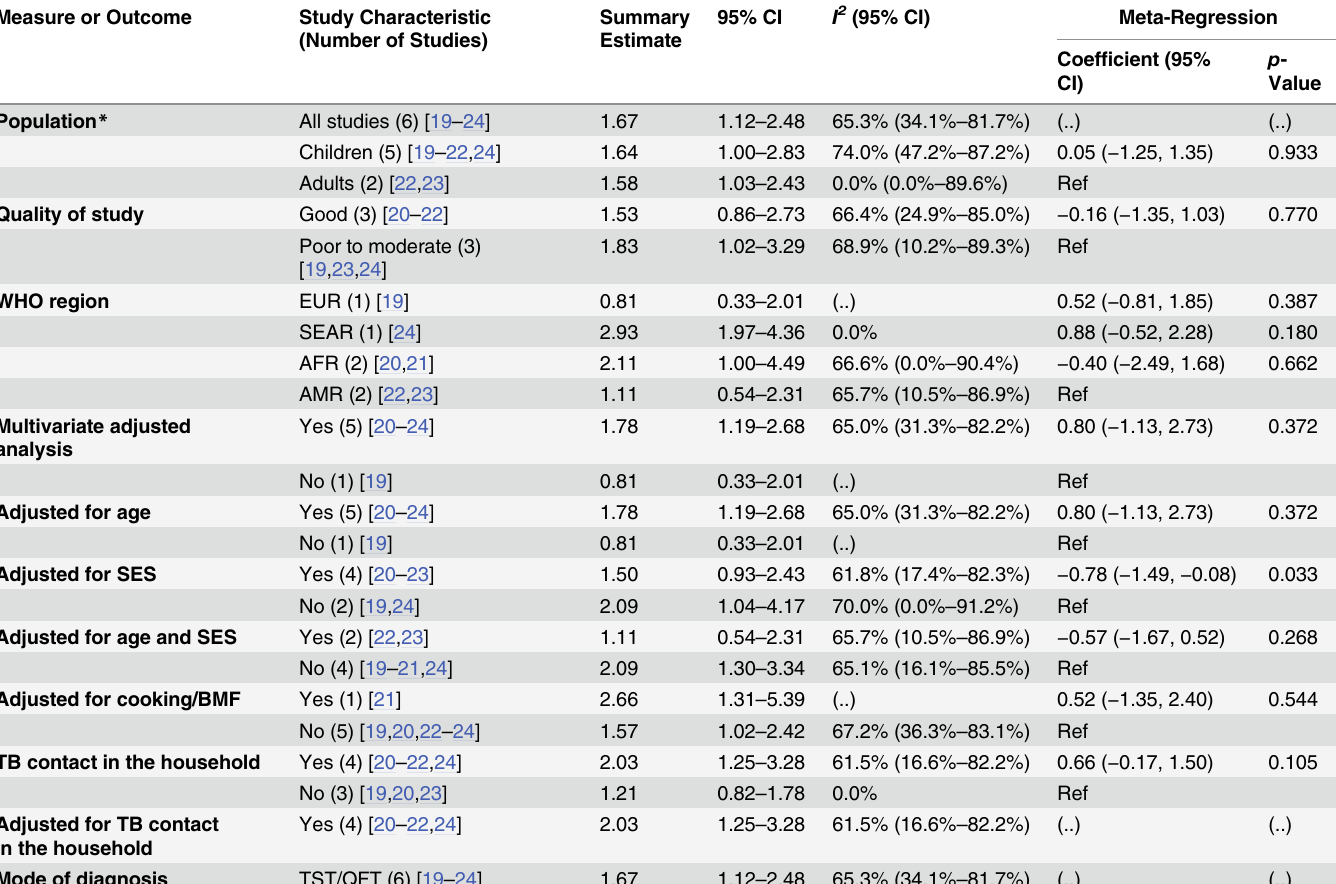
Table 2. Quality assessment and subgroup analysis: second-hand smoke exposure and latent TB